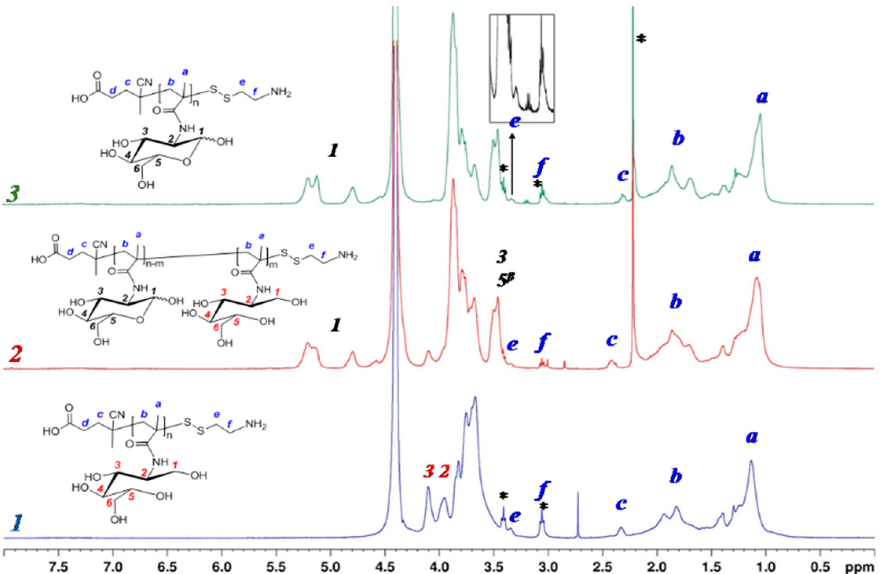
Figure 2. 1 H NMR spectra of PMAG modified by AETL: 1—NaBH 4 in DMF / water (50 / 50, v / v %), 2—NaBH 4 in DMF, 3—Et 3 N + HexNH 2 , DMF (* signals of low-molecular impurities—AETL or Table 2. Characteristics of the initial PMAG-CTA and modified PMAG-NH 2 homopolymers.